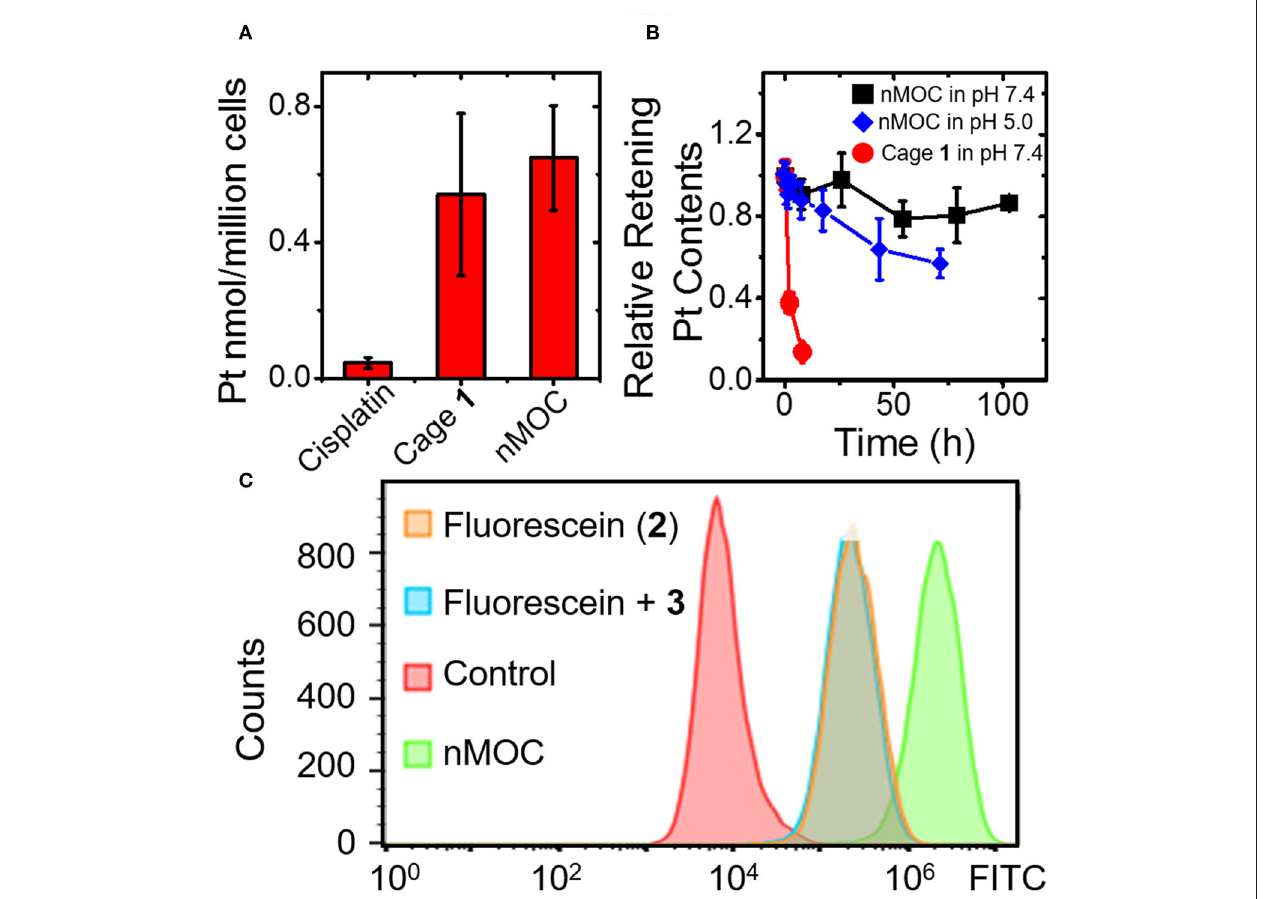
FIGURE 4 | Cellular uptake drug release profiles of the nanoparticles of MOCs. (A) Cellular uptake profiles of the different Pt compounds in A2780cis ovarian cancer cells analyzed by using GFAAS; (B) Drug release profile of nMOC and Cage 1 in PBS (pH = 7.4) or acetate buffer (pH = 5.0) at R.T.; (C) Cellular uptake profiles analyzed by using flow